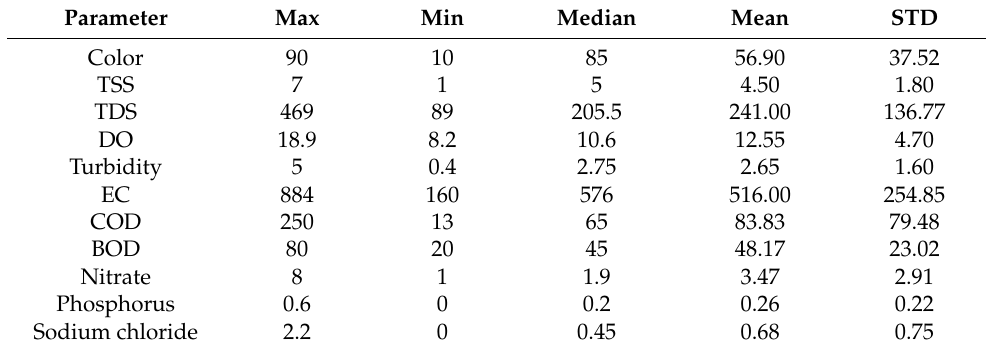
Table 5. Water quality characteristics from the samples collected from a 1 m column